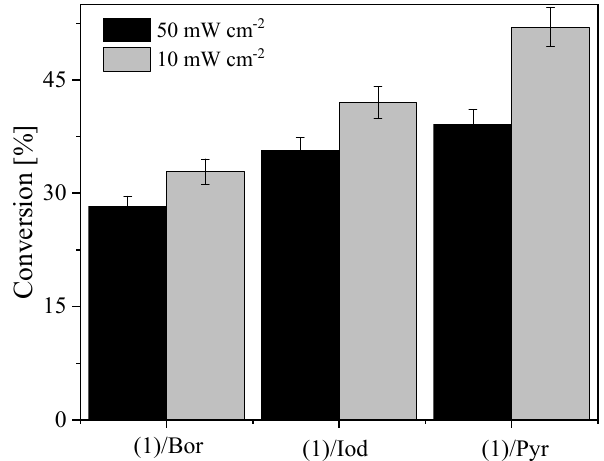
Figure 8. The effect of light intensity on the monomer conversion. The photoinitiating abilities of the systems composed of 2-phenacylbenzoxazole difluoroboranes and N -alkoxypyridinium salt (Pyr) are comparable with the commercial photoinitiators for acrylate photopolymerization, such as camphorquinone (CQ) in the presence of ethyl-4-dimethylaminobenzoate (EDMAB), diphenyliodonium chloride (I1), and N -phenylglycine (NPG), as shown in Figure 9.